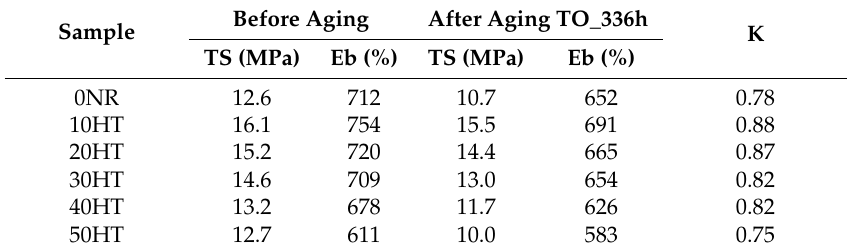
Table 7. The changes in mechanical properties before and after simulated thermo-oxidative aging processes and aging factor (K) for biocomposites. Standard deviations did not exceed: TS ± 0.6 MPa, Eb ± 11%, K ± 0.05. Before Aging After Aging Sample